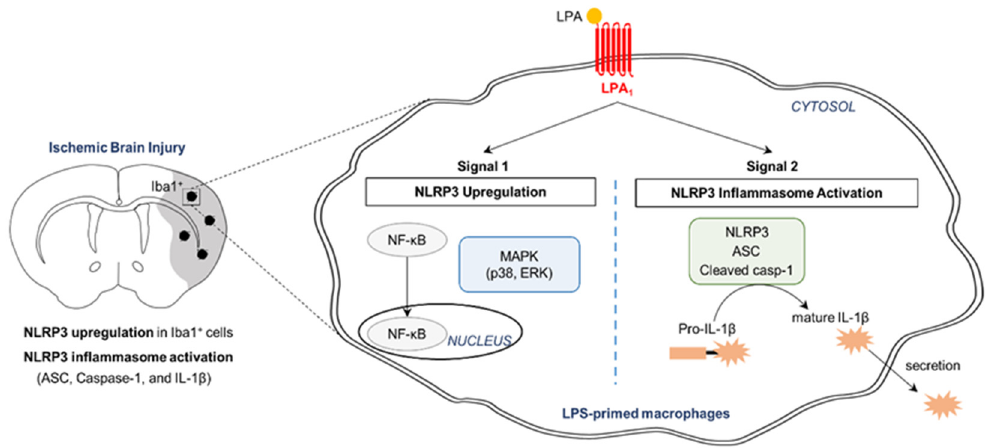
Figure 9. Schematic diagram showing the mechanism of NLRP3 inflammasome activation by LPA 1 . In injured brains after tMCAO challenge, NLRP3 is upregulated in the penumbra and ischemic core regions, particularly in cells expressing Iba1 (a marker of macrophages). NLRP3 inflammasome activation including ASC speck formation, caspase-1 activation, and IL-1 β maturation occurs in injured brains. LPA 1 contributes to NLRP3 upregulation (Signal 1) and NLRP3 inflammasome activation (Signal 2) in injured brains. In cultured macrophages, LPA 1 also regulates NLRP3 upregulation and NLRP3